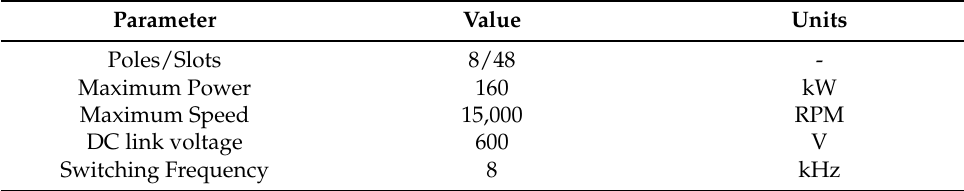
Table 1. Specifications of the traction motor with direct-oil-cooling system.